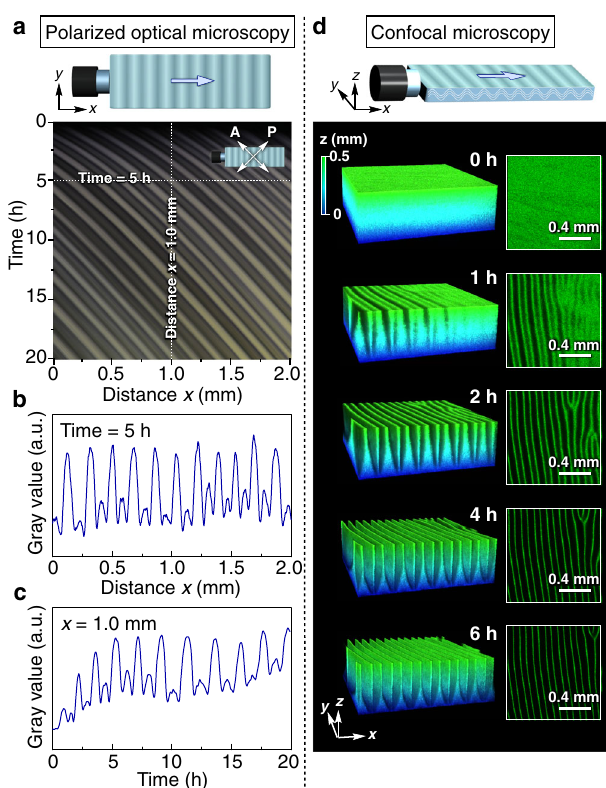
Fig. 3 Spatiotemporal characteristics of the propagating wave. a – c Spatiotemporal POM pro fi le under crossed Nicols of the propagating wave ( a ) and its gray-value pro fi les depending on distance x ( b ; at a fi xed time of 5 h) and on time ( c ; at a fi xed distance x of 1.0 mm). d Time-dependent CLSM images of the propagating wave. 2D images in a re fl ection mode were taken in a direction parallel to the xy -plane with a z -step size of 2 µ m to reconstitute 3D images, where the bright regions indicate TiNSs that are oriented parallel to the xy -plane. 3D reconstructed images sectioned at z = 0.5 mm (left) and 2D cross-sectional images at z = 0.5 mm (right). In a – d , a magnetically oriented TiNS dispersion ([TiNS] = 0.5 wt%) in a quartz cuvette (40 × 10 × 1 mm) was left at 25 °C in air (0.04% CO 2 ) to generate the propagating